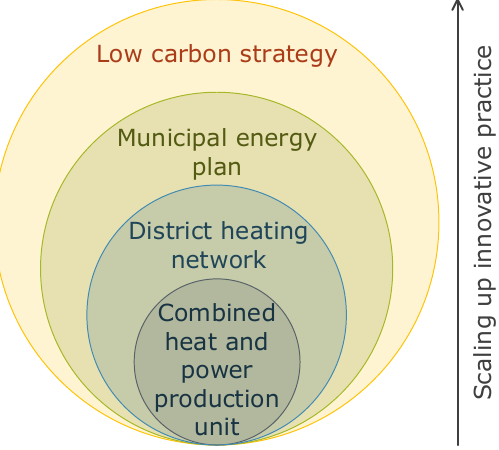
Fig. 1. Scaling-up innovative practices in energy sector using four elements in state energy sector: combined heat and power production unit, district heating network, municipal energy plan and low carbon strategy. The scaling-up framework means that the starting point is combined heat and power production unit and their operation, next step of aggregation is district heating network, followed by municipal energy plan and finally leading to low carbon